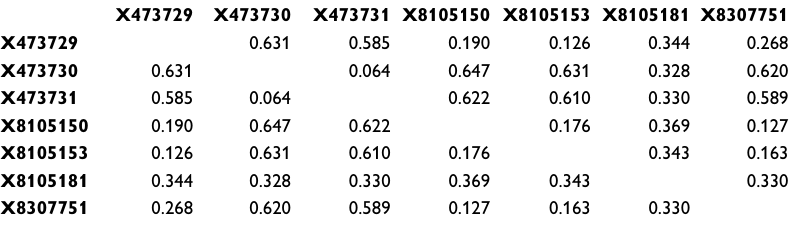
Table 1. Kolmogorov-Smirnov (KS) dissimilarity matrix of the seven selected